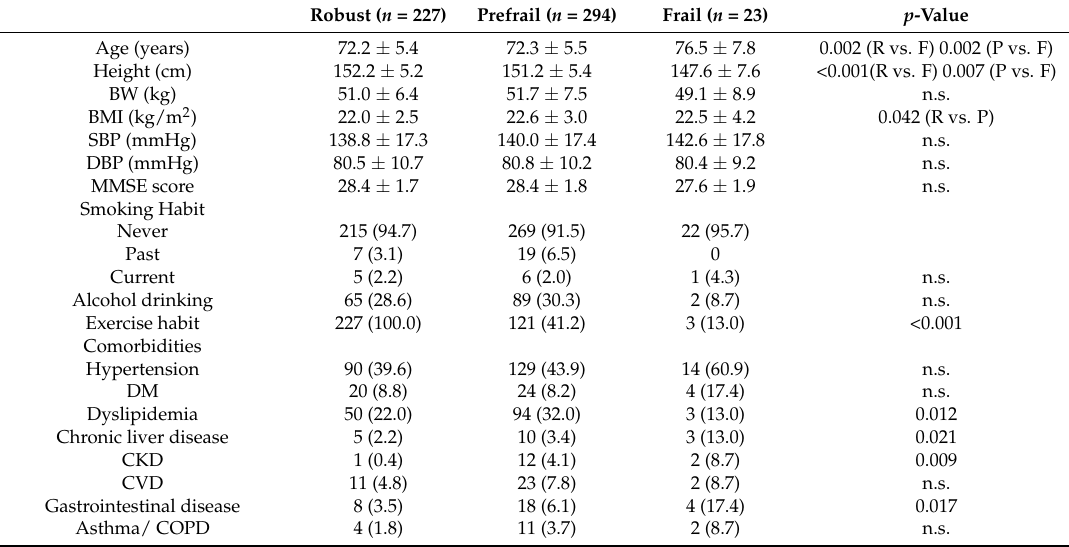
Figure 2. Comparison of macronutrient intake between robust, prefrail, and frail individuals, diagnosed by the Japanese version of the Cardiovascular Health Study. ( A ): Carbohydrate intake, ( B ): Total protein intake, ( C ): Animal and plant protein intake, ( D ): Total fat intake, ( E ): Animal and plant fat intake, and ( F ): Total, soluble, and insoluble dietary fiber intake. ∗ : p < 0.05 vs. Robust. Table 4. Basic characteristics and dietary habits among frail, prefrail, and robust men, as diagnosed As shown in Table 5, age was the highest and the height was the lowest in the frail female group by the J-CHS criteria. between the three groups. BMI was significantly higher in the prefrail female group, compared with that in the robust female group. In addition, the frail female group had the lowest exercise status. The proportion of chronic liver disease, CKD, and gastrointestinal disease was significantly higher and that of dyslipidemia was significantly lower in the frail female group. Table 5. Basic characteristics and dietary habits among frail, prefrail, and robust women, as diagnosed by the J-CHS